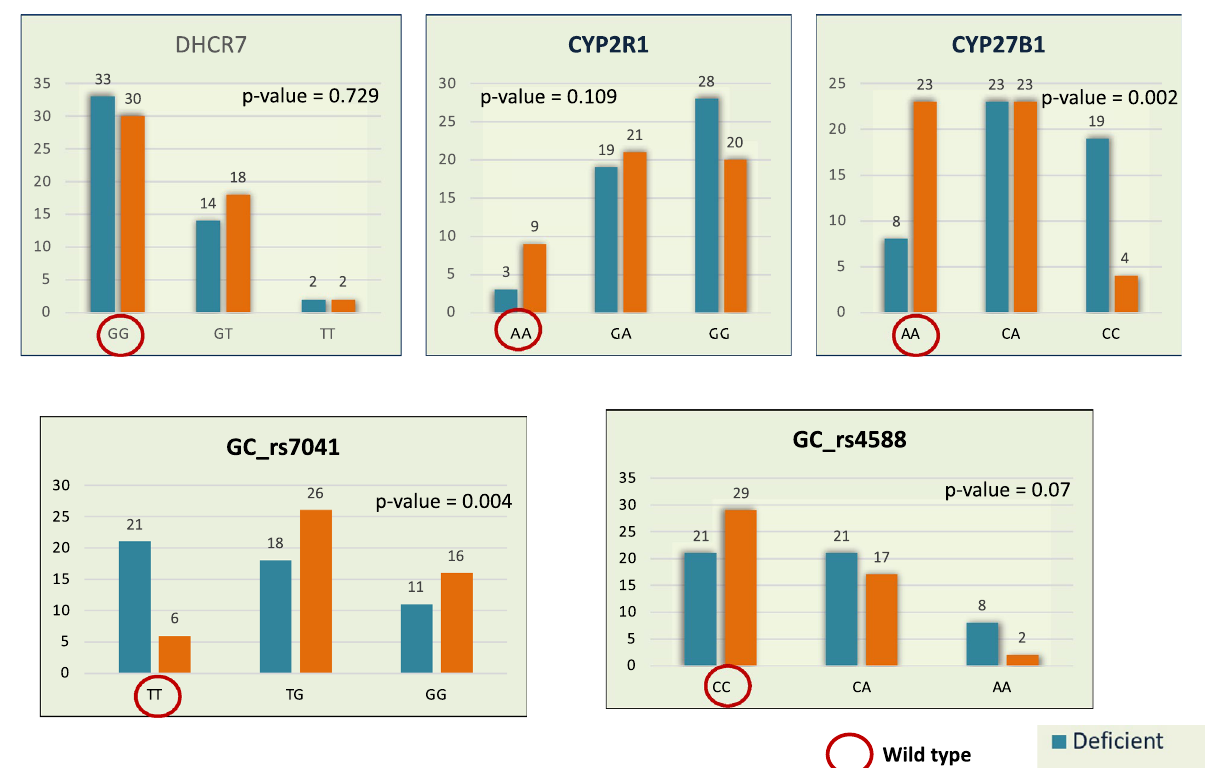
Figure 2. Distribution of different genotypes in deficient (n = 50) and non-deficient (n = 50) groups (p-values were generated from Chi-square test/Fisher exact